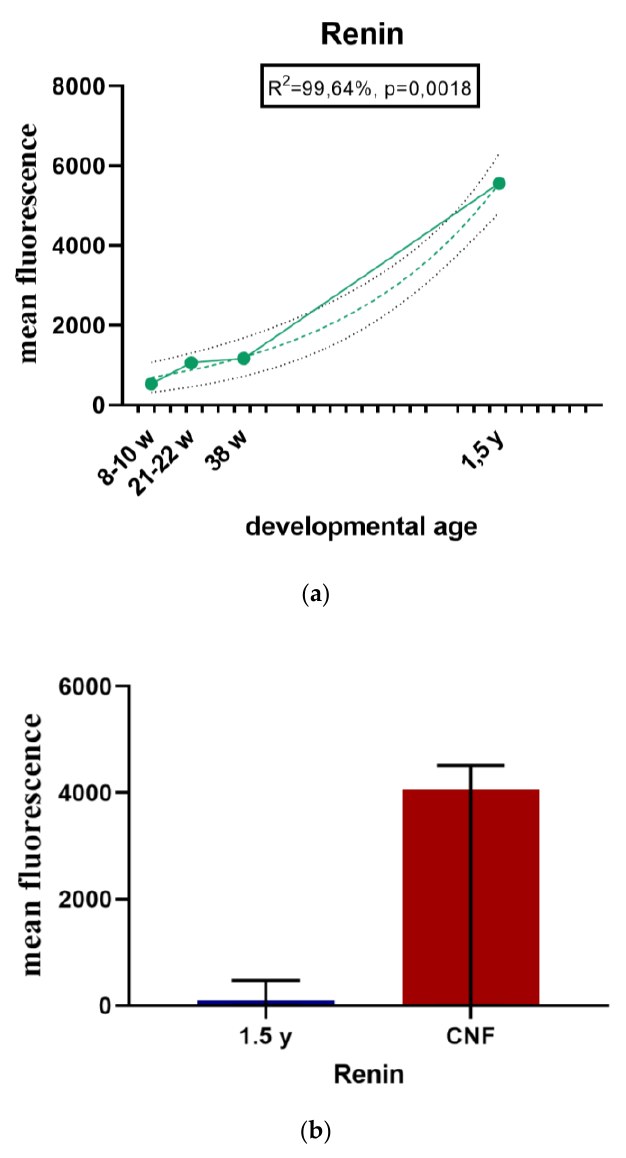
Figure 6. ( a ) Renin expression in the JGA region of developing and postnatal human kidneys shown by scatter plot; ( b ) Renin expression in the JGA region of healthy and CNF postnatal kidneys (median ± interquartile range for technical replicates).